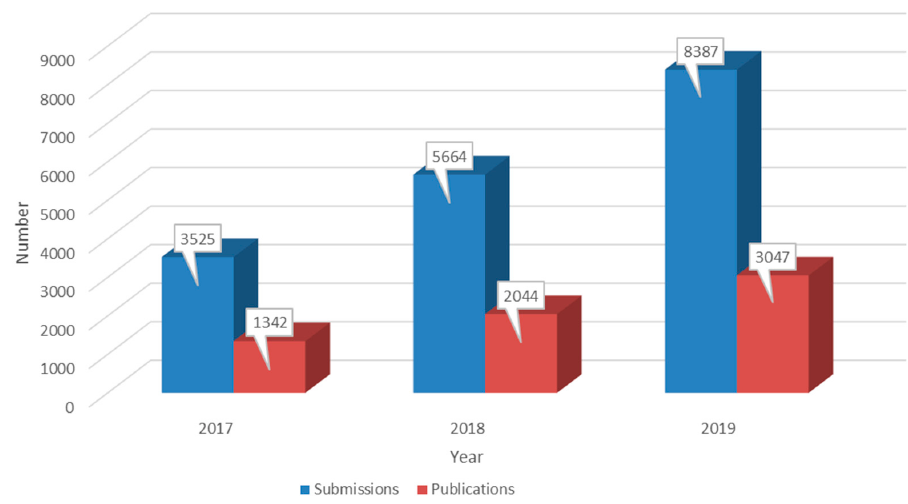
Figure 1. Number of submissions and publications in the past three years for the Remote Sensing Open Access Journal of MDPI.